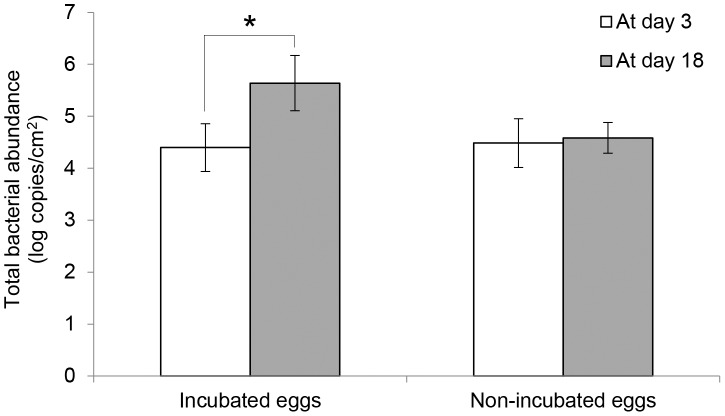
Changes in the microbial abundance on incubated and non-incubated eggs.Total bacterial abundance was estimated with log-copy numbers per square centimeter obtained from quantitative PCR with a bacterial universal primer set (333F-518R) in 9 incubated nests and 3 control nests at day 3 (before incubation) and day 18 (after incubation). Asterisks represent significant difference (P<0.05) by paired t-test between day 3 and day 18. Error bars denote standard errors.